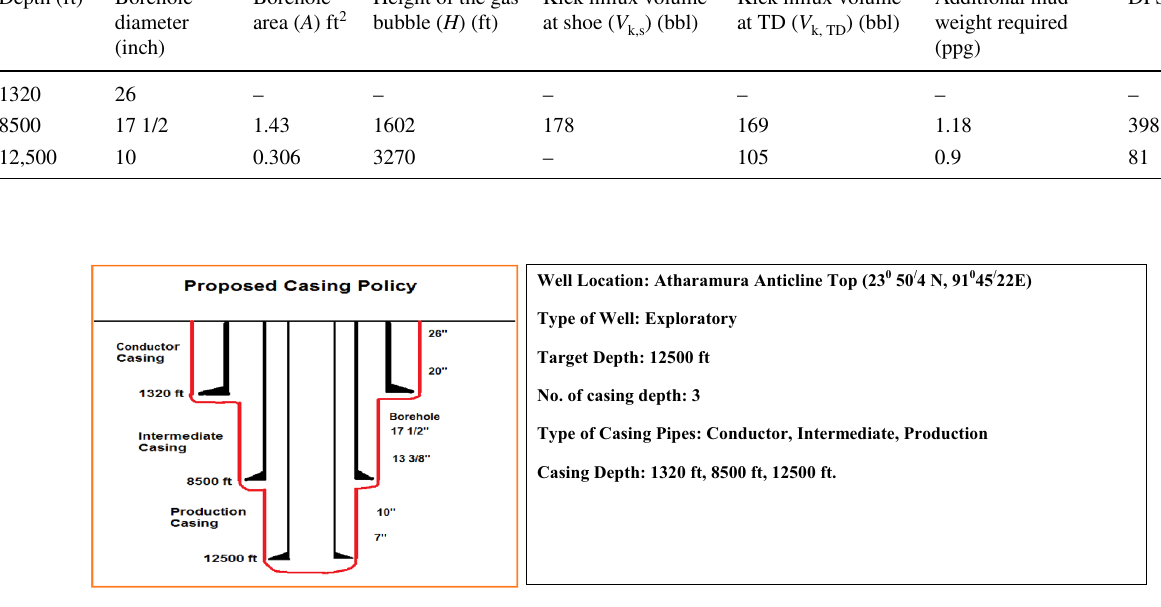
Fig. 12 Proposed casing policy on the top of Atharamura